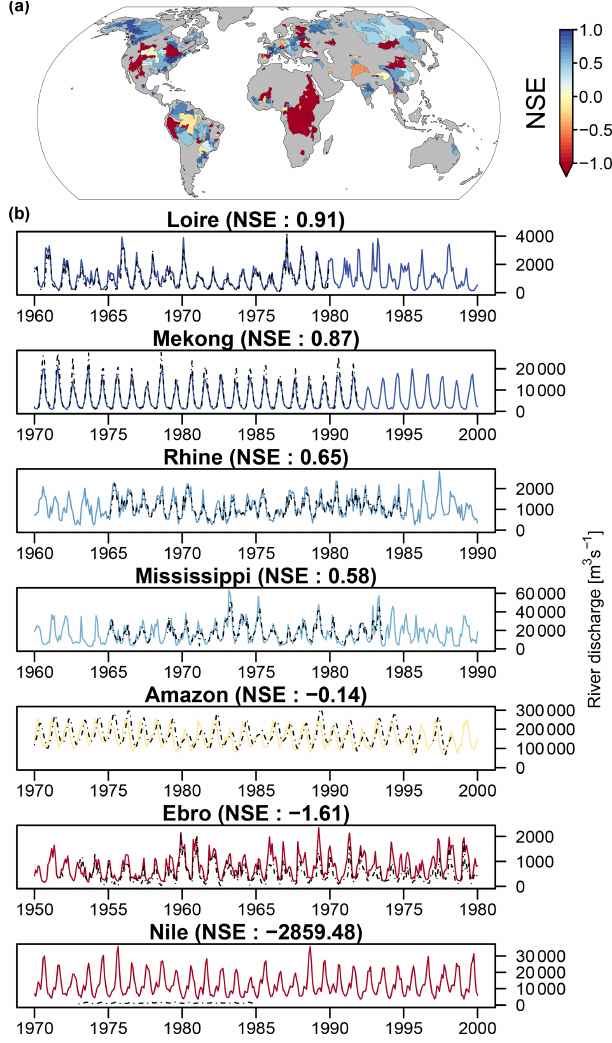
Figure 5. Validation results based on selected GRDC river dis- charge observations. (a) Spatial distribution of the NSE skill for selected GRDC large basins. (b) Observed (dashed black line) and predicted (coloured) river discharge time series. Line colours corre- spond to the NSE skill shown in panel (a) .